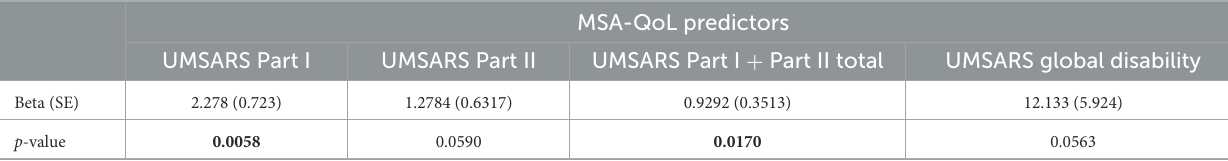
TABLE 5 Linear regression model results for MSA-QoL total score, not adjusted for age, sex, disease duration, or MSA type.